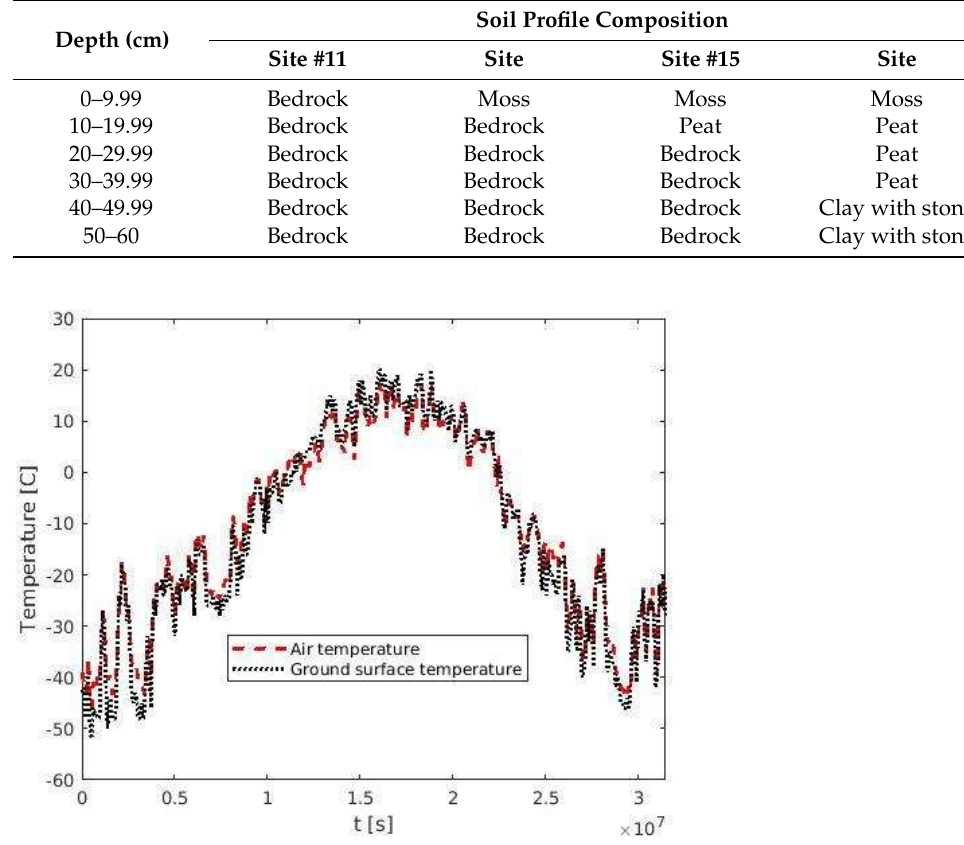
Figure 5. Air and ground surface temperatures recorded in 1962 at Nizhnyaya meteorological sta-